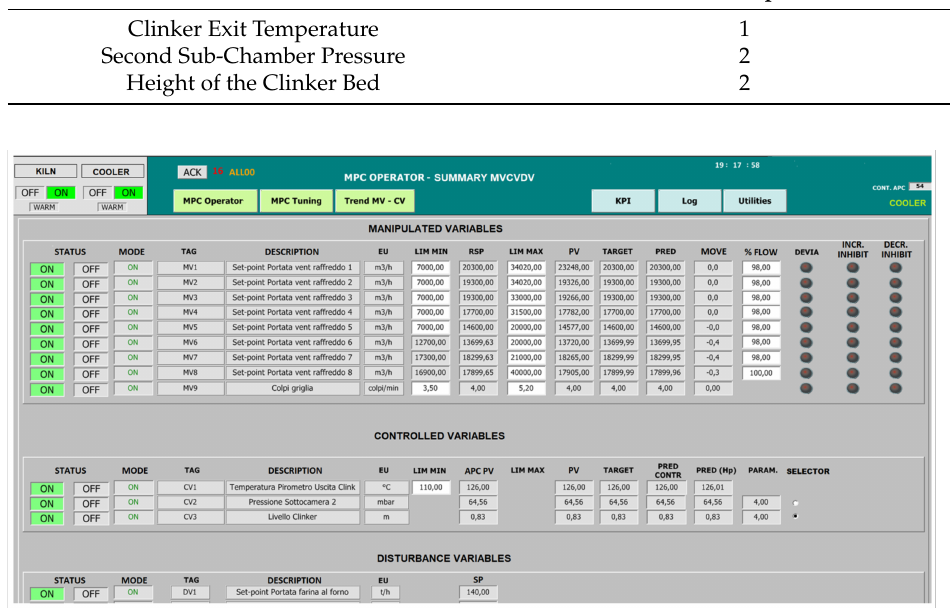
Figure 7. Grate cooler APC system: example of process variables GUI